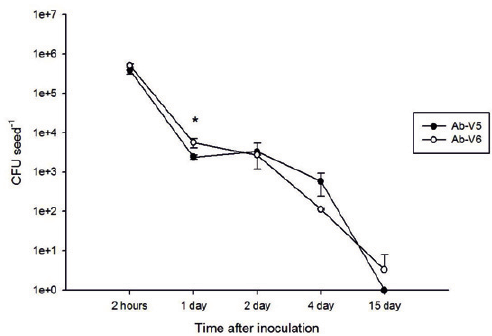
Fig. 2. Concentration of viable cells of Azospirillum brasilense recovered from maize seeds after different periods of inoculation. The data represent the means of three replicates and the bars denote the standard error. (*) treatments that differ from each other by the Tukey’s test at p < 0.05; without (*) indicates that values were not statistically